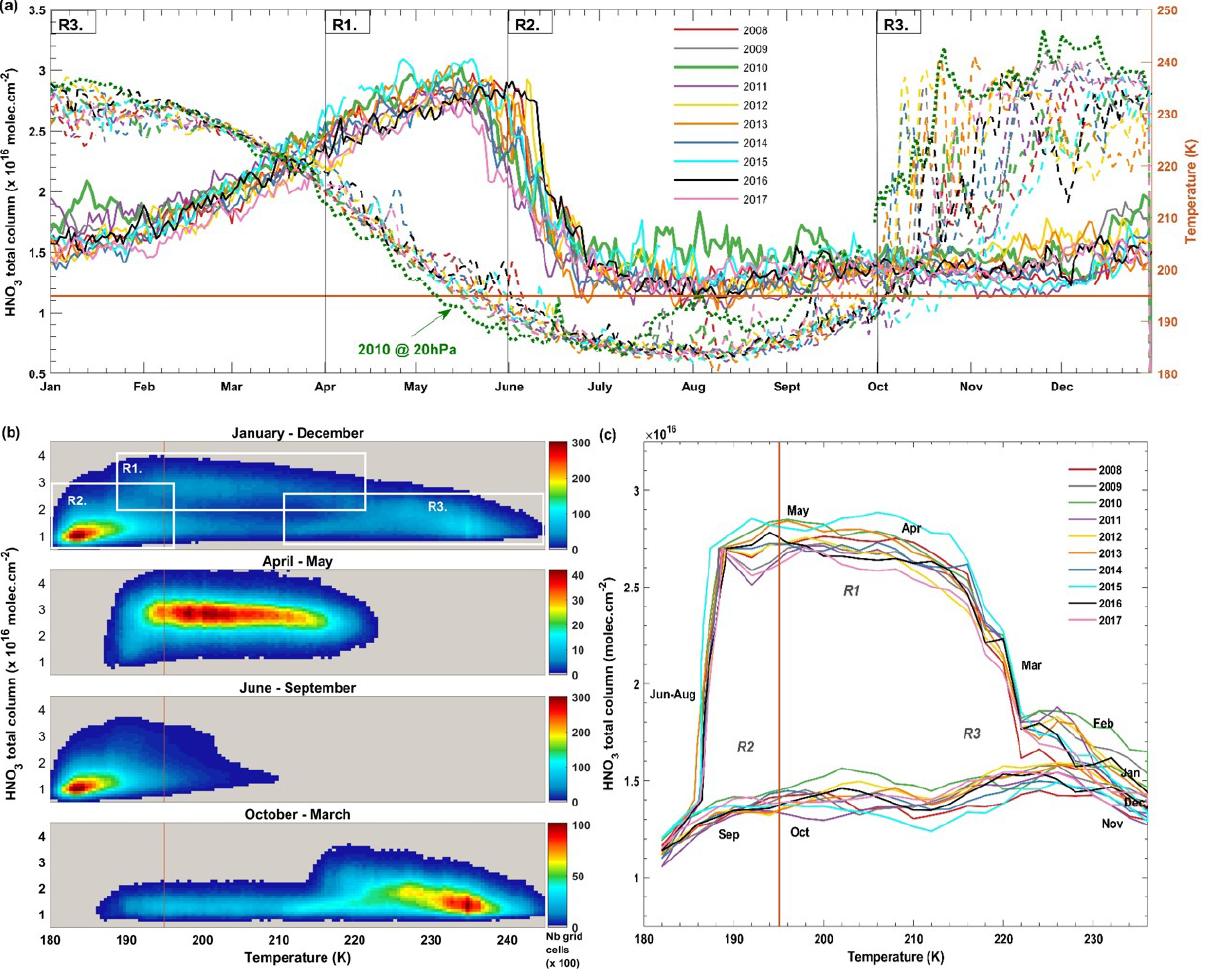
Figure 3. (a) Time series of daily averaged HNO 3 total columns (solid lines) and temperatures taken at 50hPa (dashed lines) in the 70–90 ◦ S equivalent latitude band for the years 2008–2017. The dotted green line represents the temperatures at 20hPa for the year 2010. (b) HNO 3 total columns vs. temperature (at 50hPa) histogram during the year 2011, over the whole year (a) and for the three defined regimes (R1–R3) separated in (a) . The colors refer to the number of gridded measurements in each cell. (c) Evolution of daily averaged HNO 3 total columns with the highest occurrence (in bins of 0.1 × 10 16 molec . cm − 2 and 2K) as a function of the 50hPa temperature for the years 2008–2017. The horizontal or vertical orange lines represent the 195K threshold